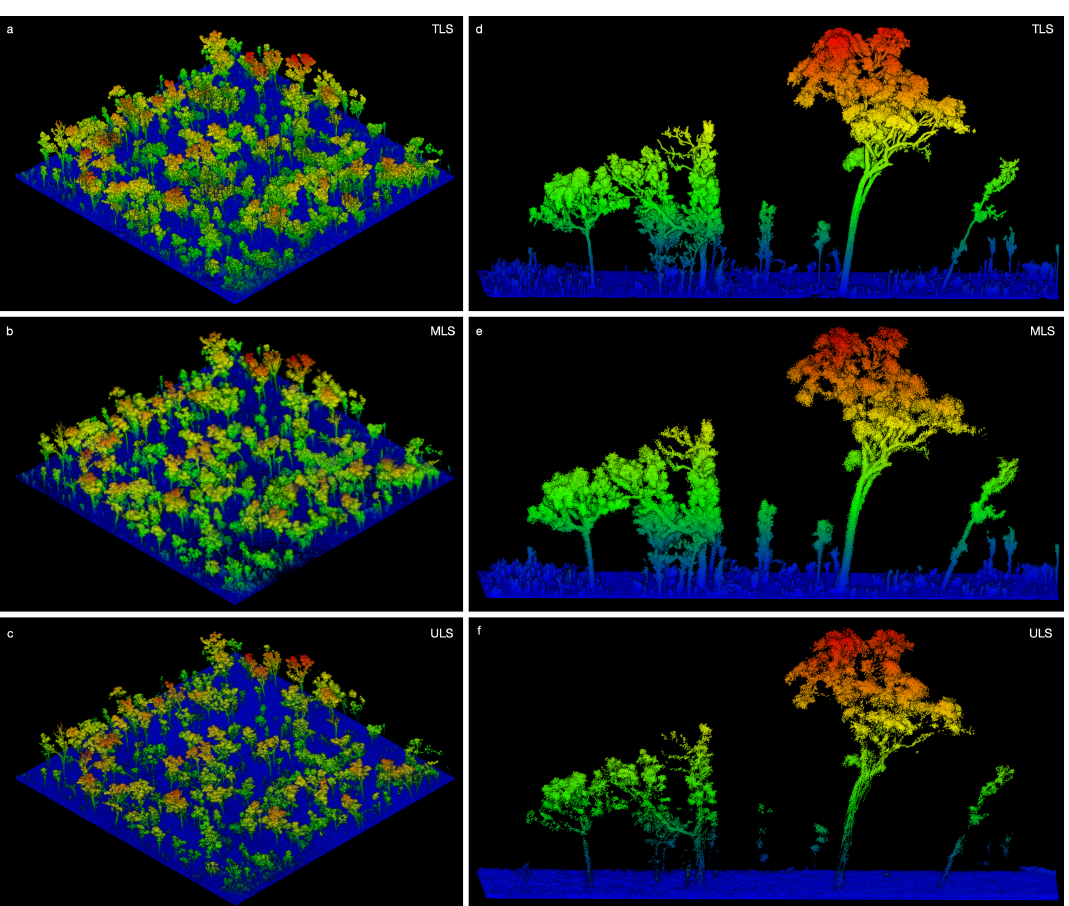
Figure 5. Oblique view of the point clouds derived from the three LiDAR platforms: ( a ) TLS, ( b ) MLS and ( c ) ULS. Cross-sectional view of the point clouds derived from: ( d ) TLS, ( e ) MLS, and ( f )